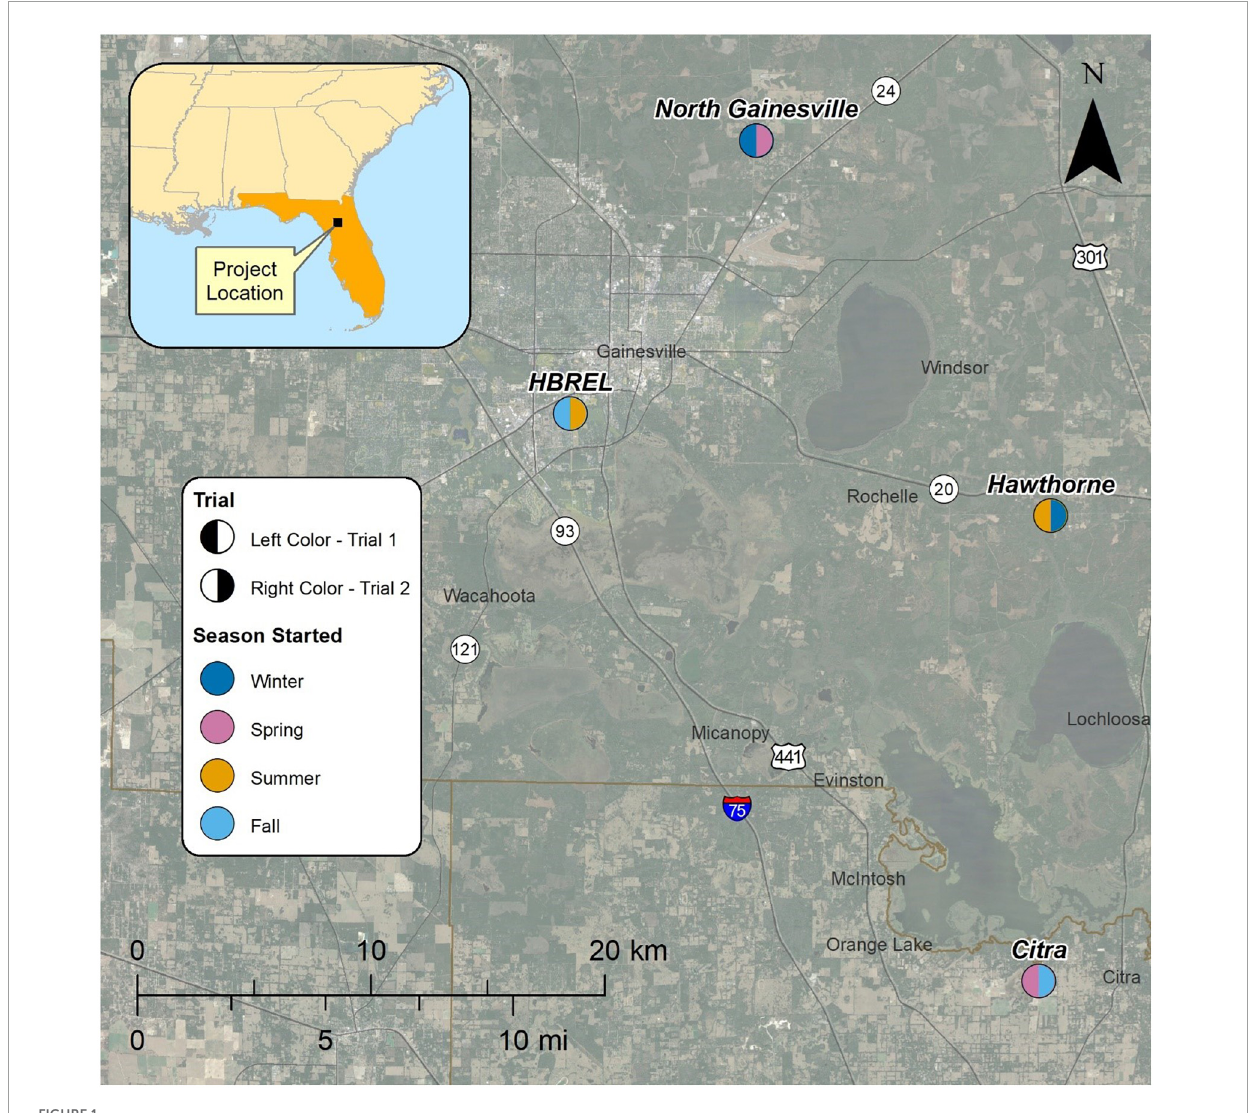
FIGURE1 Satellite image of apiary locations used in both trials (image by Google Earth). Figure legend indicates the assigned season and trial used in each location.